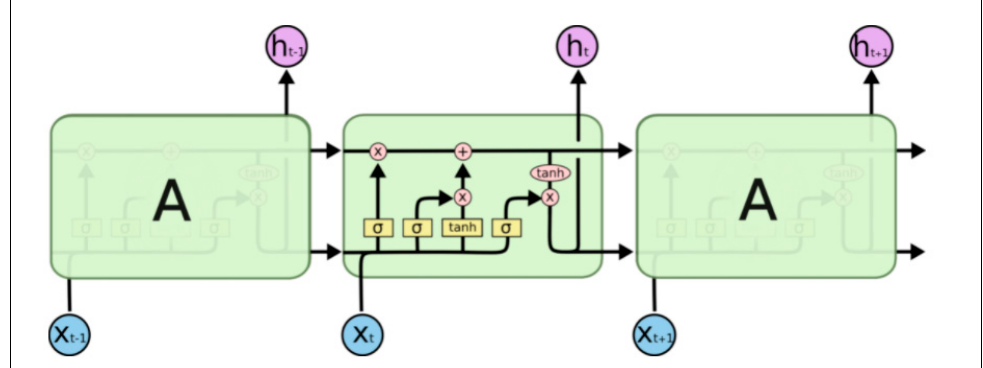
Figure 3. The structure of Long Short-Term Memory (LSTM). Adapted from [20].